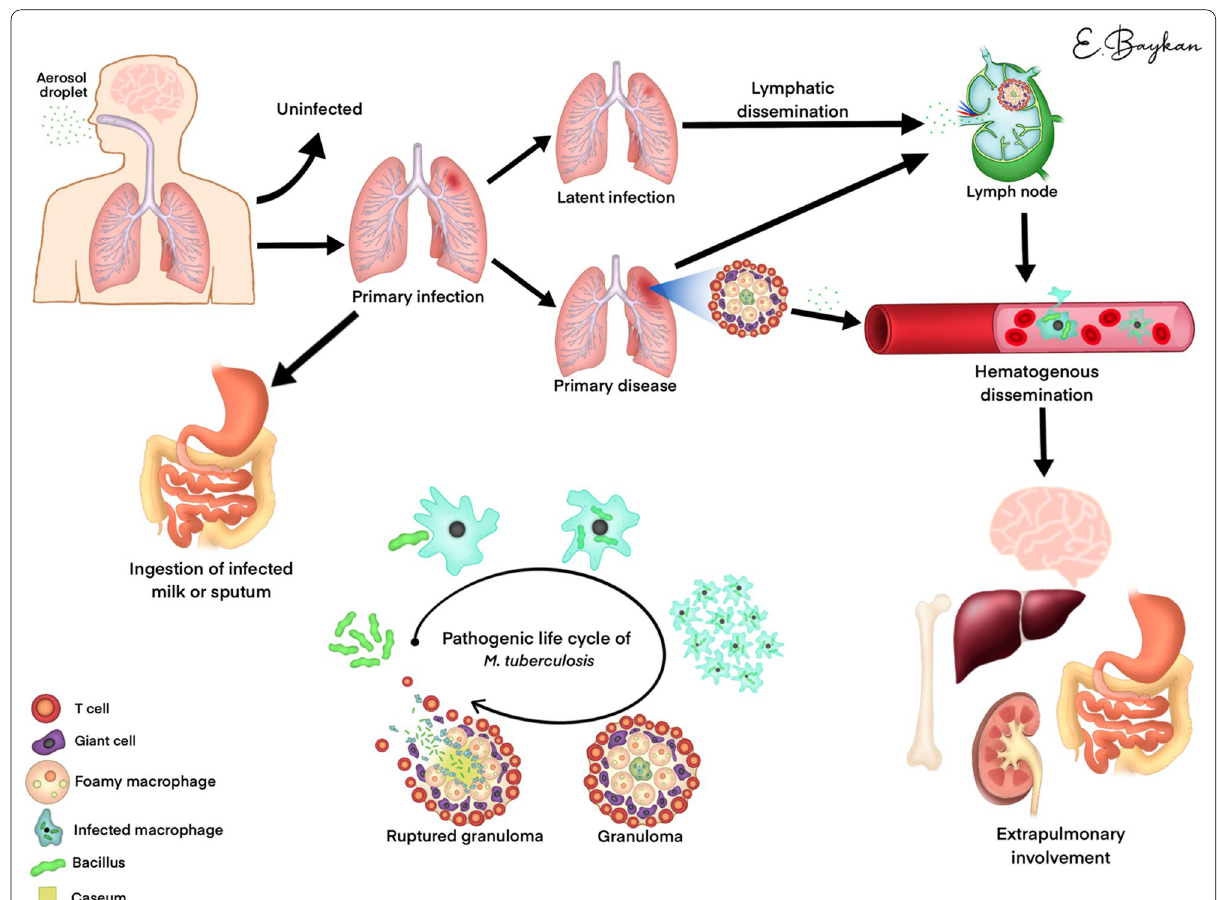
Fig. 1 Pathogenic life cycle and extrapulmonary dissemination of M. tuberculosis